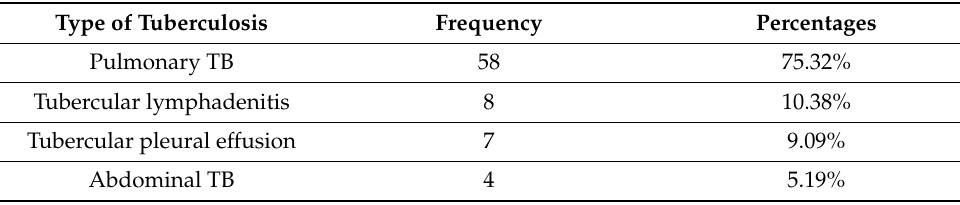
Table 2. Descriptive analysis of type of TB in the study population. Type of